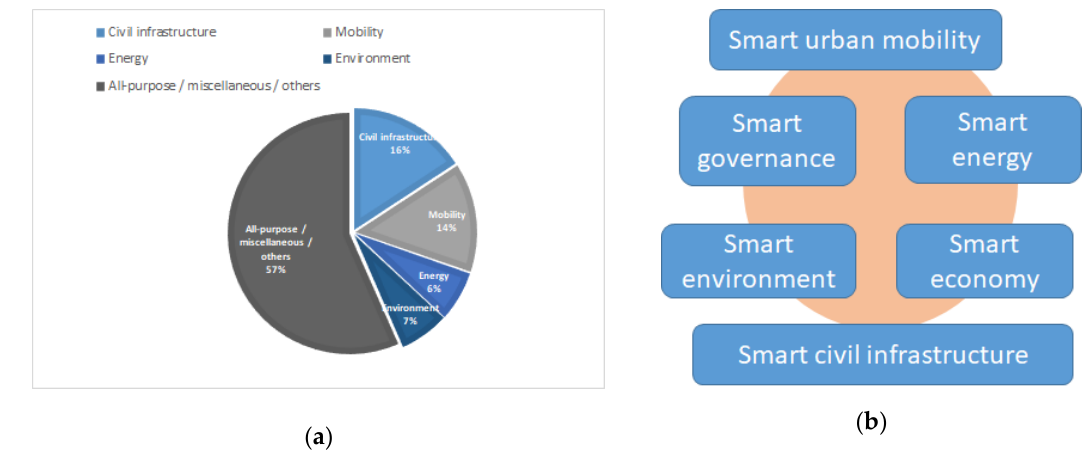
Figure 1. Smart Cities services analyses 2010–2018. Data extracted from the study done in [42]: ( a ) percentage of appearance in papers; ( b ) main areas of interest for deploying Smart City services.